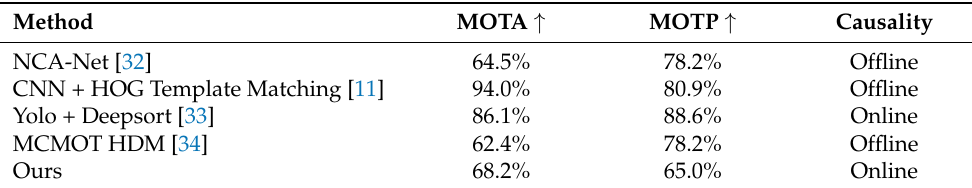
Table 6. Comparison with state-of-the-art methods on testing the subset of EPF multi-cameras pedestrian